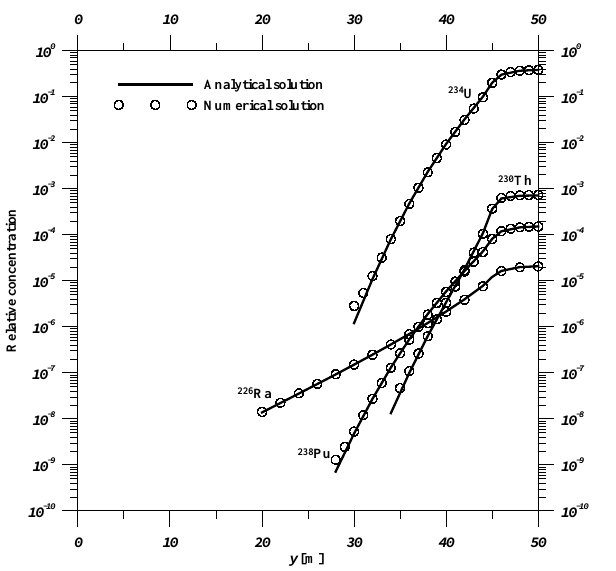
Fig. 7. Figure 7. Comparison of spatial concentration profiles of four Fig. 6 Figure 6. Comparison of spatial concentration profiles of four species along the transverse direction ( = 25m) at t = 1000years species along the transverse direction ( = 0m) at t = 1000years ob- obtained from derived analytical solutions and numerical solutions tained from derived analytical solutions and numerical solutions for convergence test example 2 of four-member radionuclide decay for convergence test example 2 of four-member radionuclide decay chain 238 Pu → 234 U → 230 Th → 226 chain 238 Pu → 234 U → 230 Th → 226 Ra.